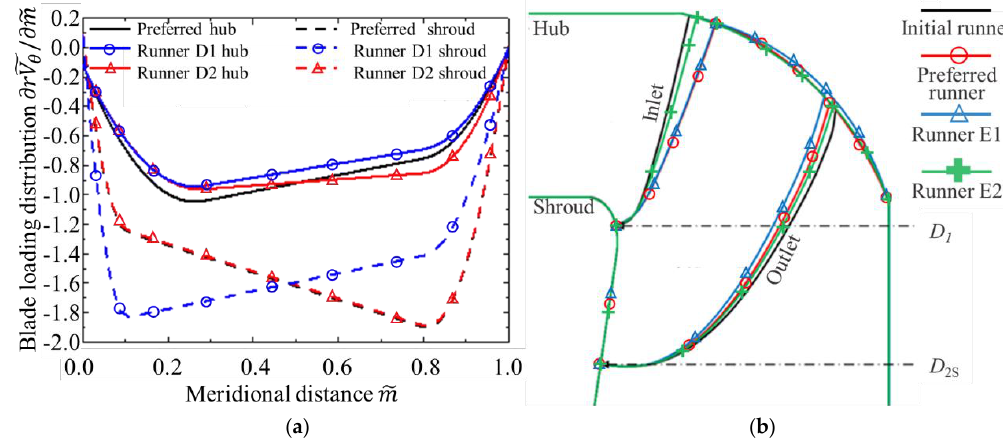
Figure 11. Comparison among different runners. ( a ) Blade loading distributions; ( b ) Meridional channel.